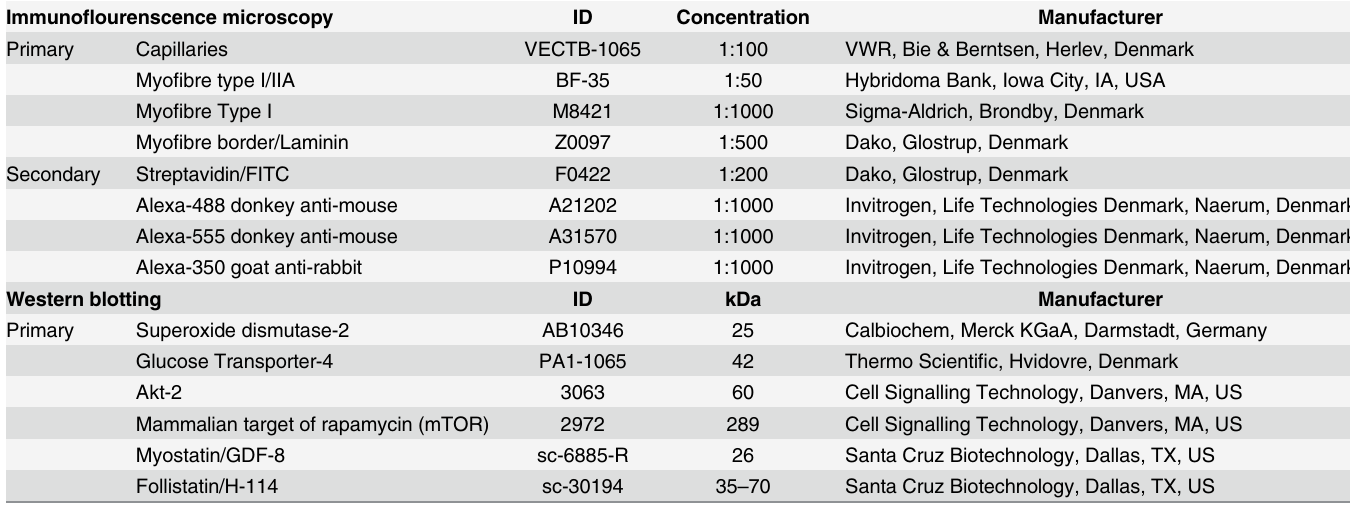
Table 1. List of